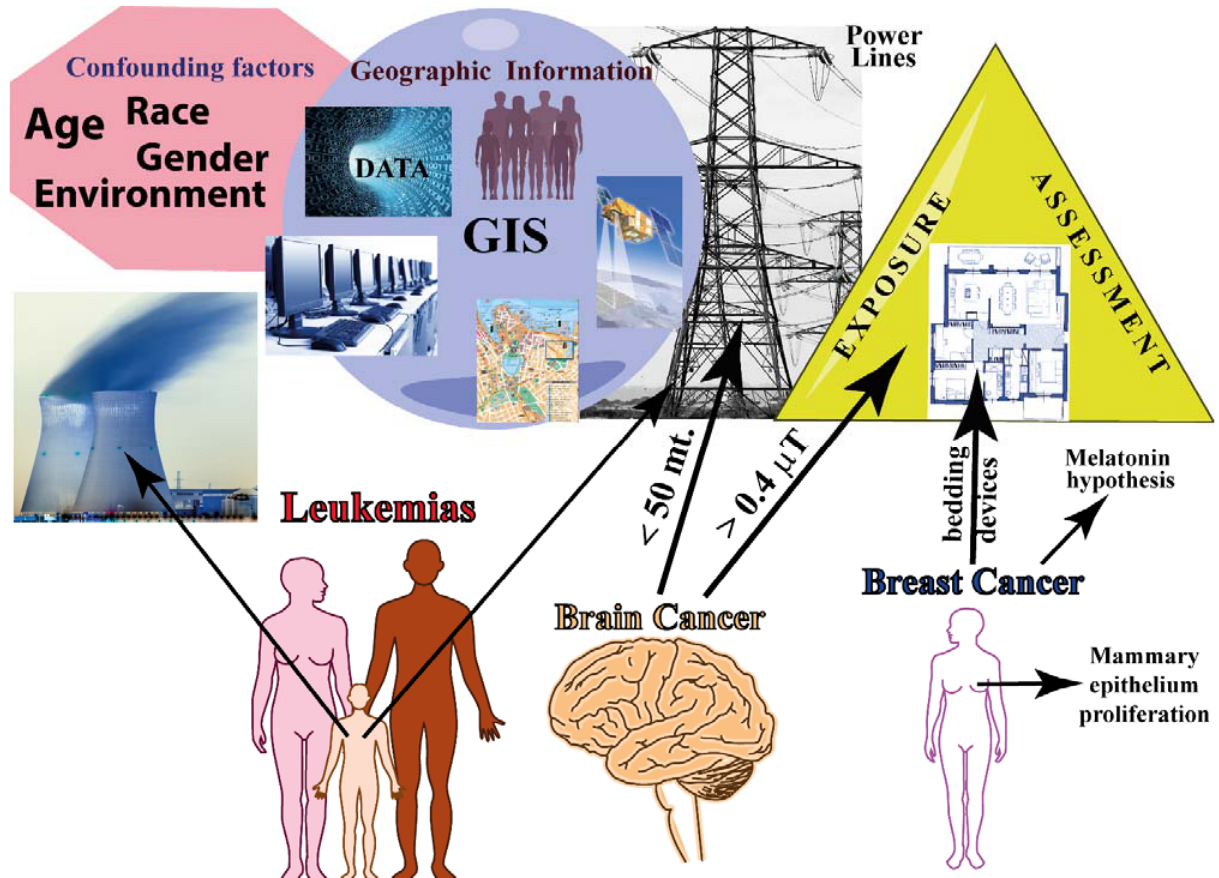
Figure 2. Summary of epidemiology of residential/domestic exposure to MF. The major confounding factors in epidemiological studies are shown along with the main geographical information that is based on GIS (data management, hardware/software, topography, remote detection, and population demographics). Exposure assessment needs to be evaluated both outside and inside the residence. The three major cancers are represented: leukemia affects mainly childhood; brain cancer increases with decreasing distances from EMF sources; and breast cancer is associated with mammary epithelium proliferation and with exposure to bedding devices.